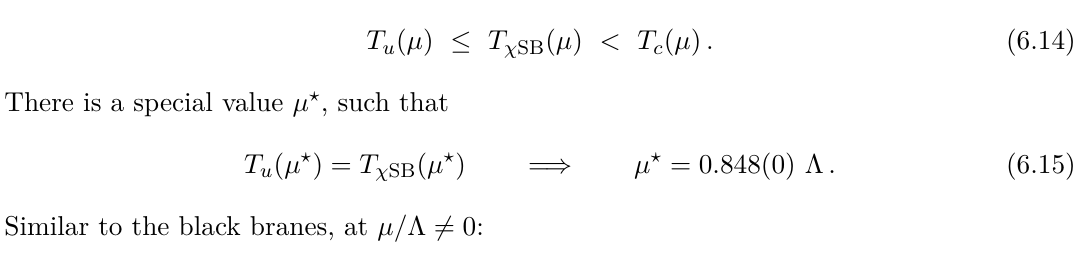
Figure 21 . Left panel: the reduced Kretschmann scalar ˆ to µ/ Λ = 0 deconfined stated of the theory normalized to ˆ states is associated with collapsing of the conifold 2-cycle (the central panel), and of is associated with collapsing of the deformed T 1 , 1 (the right